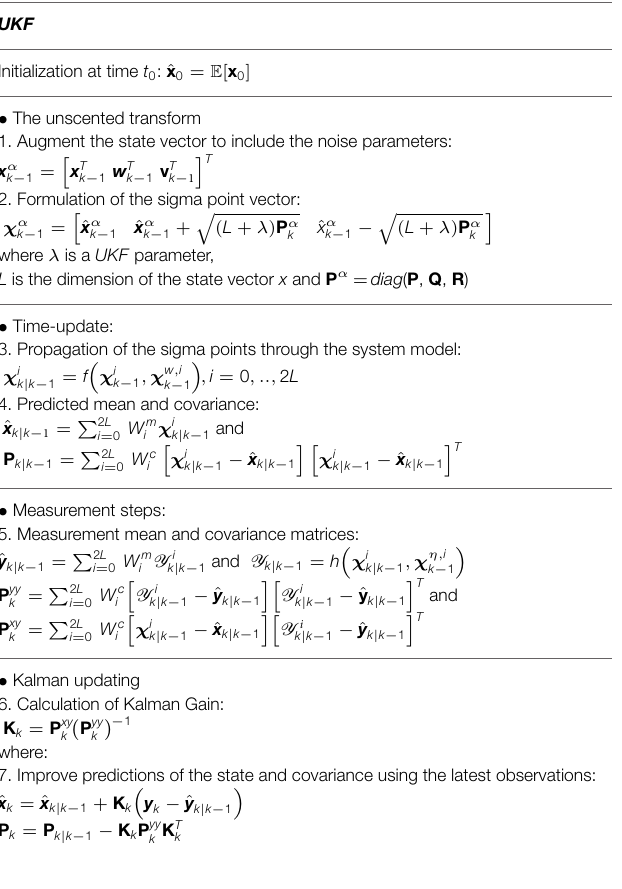
Asinferred bythestepsoutlinedabove,the UKF algorithm does not discern between observable/unobservable states and identi- fiable/unidentifiable parameters. The overall convergence of the TABLE 1 | The steps of the UKF